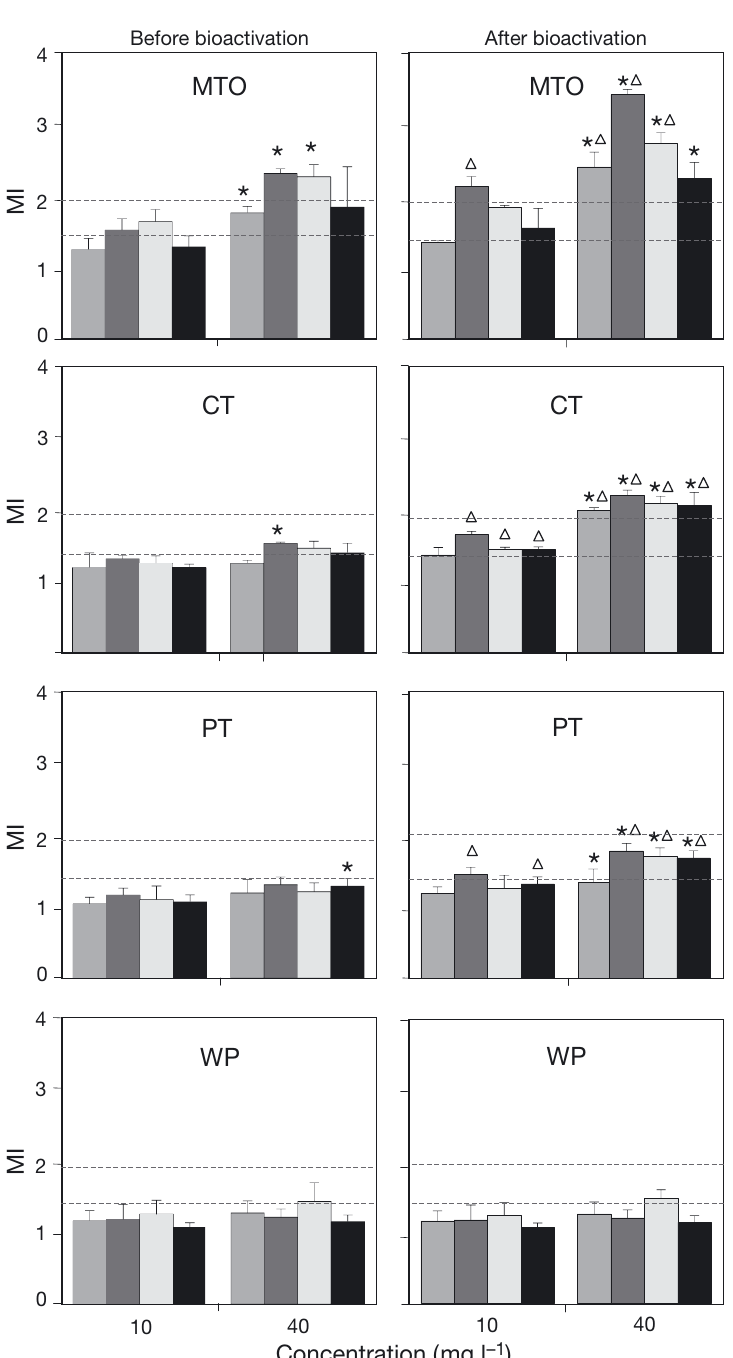
Fig. 4. Mutagenicity index (MI) of different concentrations of compounds used to clean mussel rafts analysed by the Vibrio harveyi test before and af- ter metabolic activation with the S9 fraction from the liver of male Wistar Han rat. Bars = 1 SD. Tested compounds: mixture of petroleum tars and diesel combusted oil (MTO); commercial coal tar (CT); tar of pine wood (PT); waterproof paint (WP). V. harveyi strains: BB7 ( j ); BB7M ( j ); BB7X ( j ), and BB7XM ( j ). Limits of MI values (dashed lines): potentially muta- genic (1.5 < MI < 2) and mutagenic (MI > 2).  : significant increase of MI with the compounds concentration (p < 0.01); Δ : significant increase